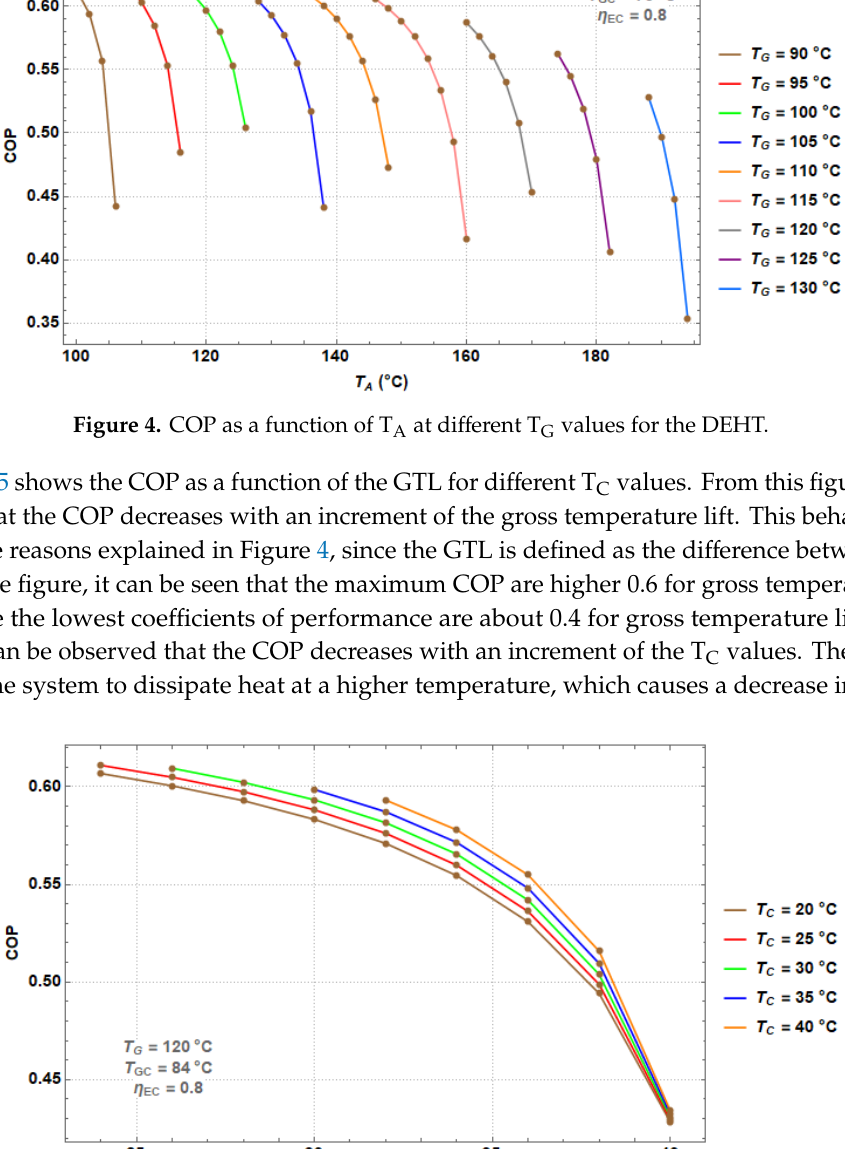
Figure 6. COP as a function of T G at different T C values for the DEHT. Figure 7 shows the variation of the COP as a function of the flow ratio. It can be seen that the flow ratio is a critical variable in the system performance since the coefficient of performance rapidly decreases with the increment of this parameter. This behavior is justified by the flow ratio definition, since an increment of the flow ratio means that the amount of the working fluid decreases with respect to the solution flowing from the generator to the absorber, causing that a higher amount of energy to be supplied to the generator, thus reducing the coefficient of performance. Besides, the COP decreases with an increment of T C for the reasons explained in Figure 5.